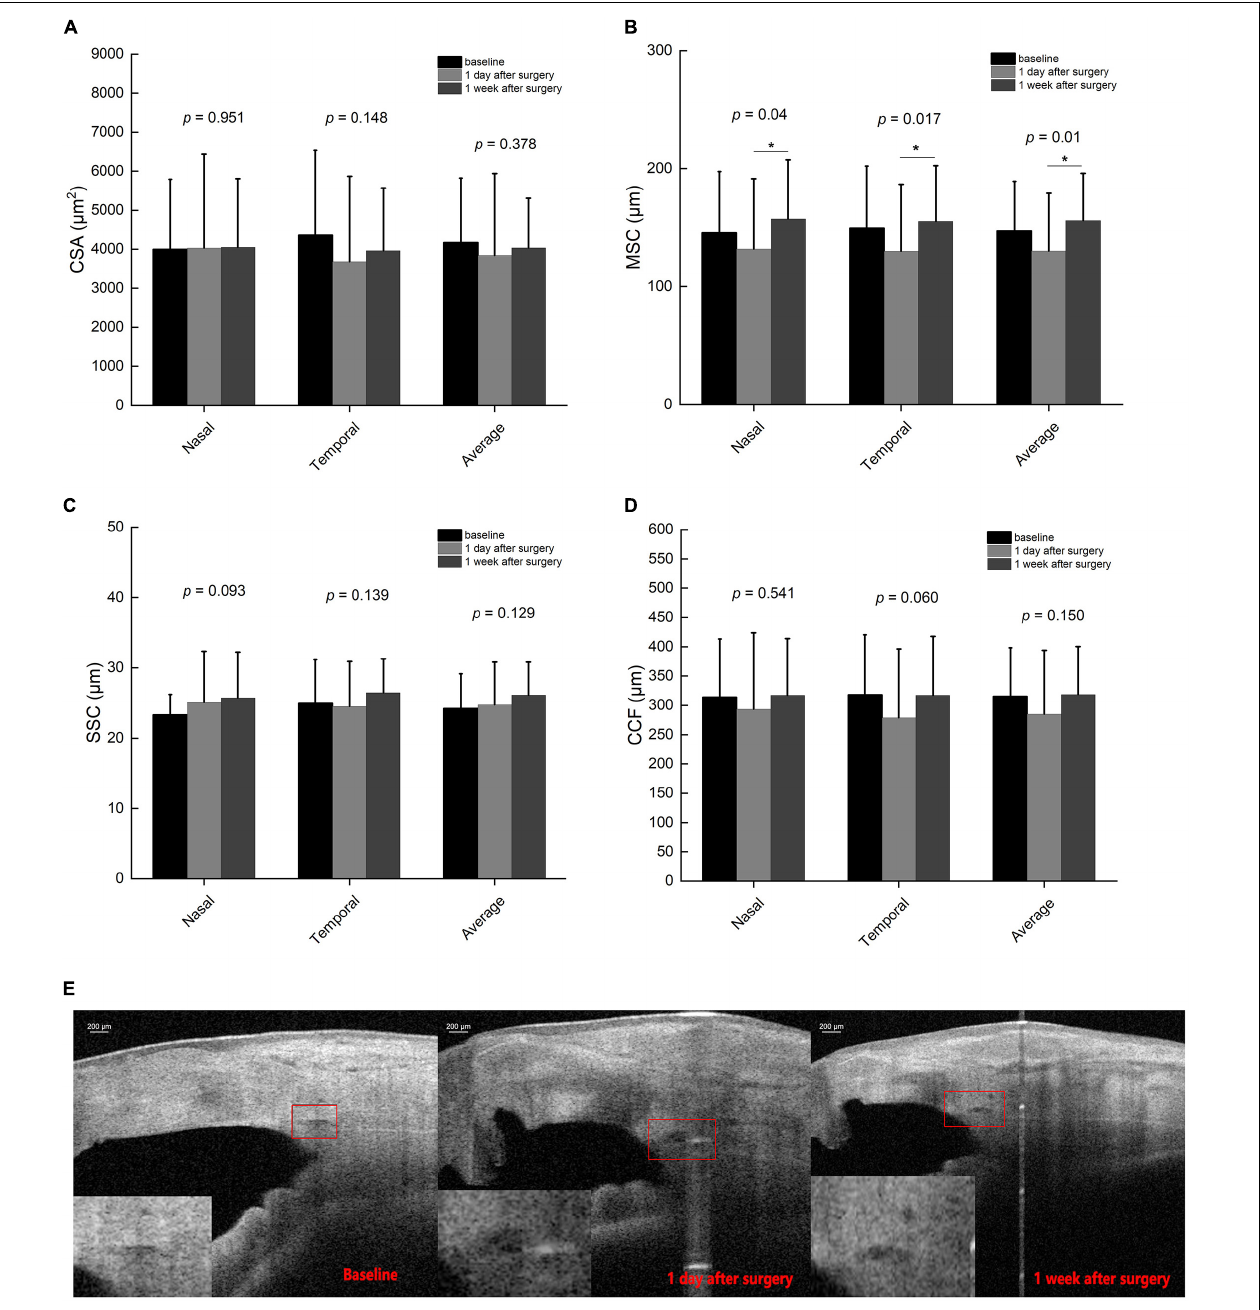
FIGURE 3 | Schlemm’s canal (SC) parameters including cross-sectional area (CSA) (A) , sagittal diameter of SC (SSC) (C), and circumference (CCF) (D) did not show significant differences among preoperative and postoperative time points, except meridional diameter of SC (MSC) (B) . The SC morphology varied at different time points before and after surgery (E) . *Indicates statistical difference between date